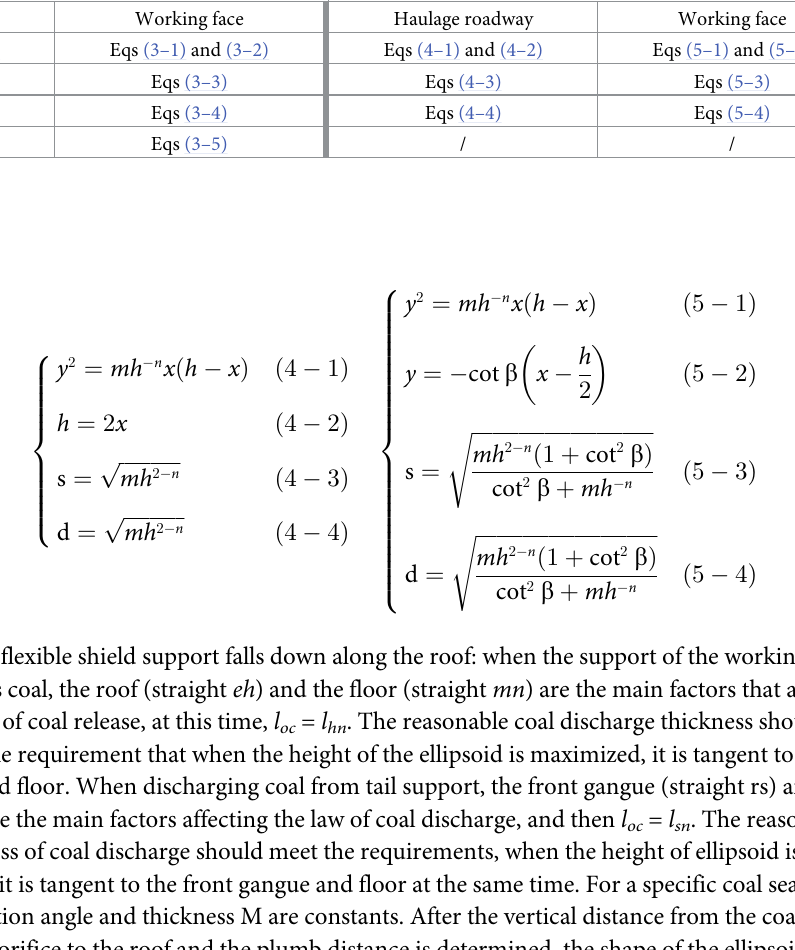
Table 3. Shape, boundary conditions and process parameters of the drawing body. Fall Along the